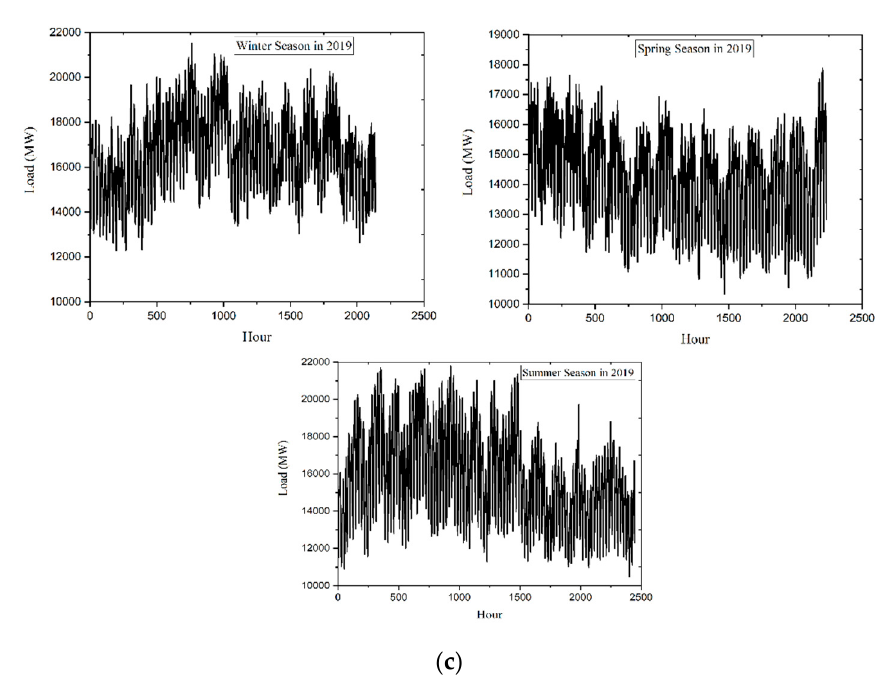
Figure 5. Input load series from 1 January 2018 to 30 September 2019 (IESO-Canada) ( a ) Input load data from IESO-Canada database; ( b ) Seasonal input data during the year 2018; ( c ) Seasonal input data during the year 2019.